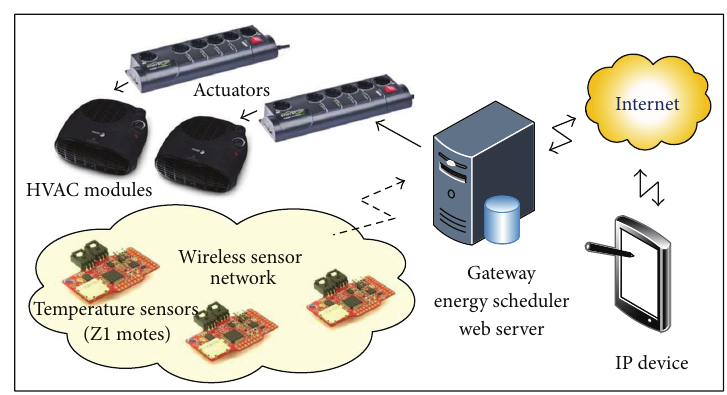
Figure 1: Overall architecture of the proposed HVAC energy scheduler in the IoT context.